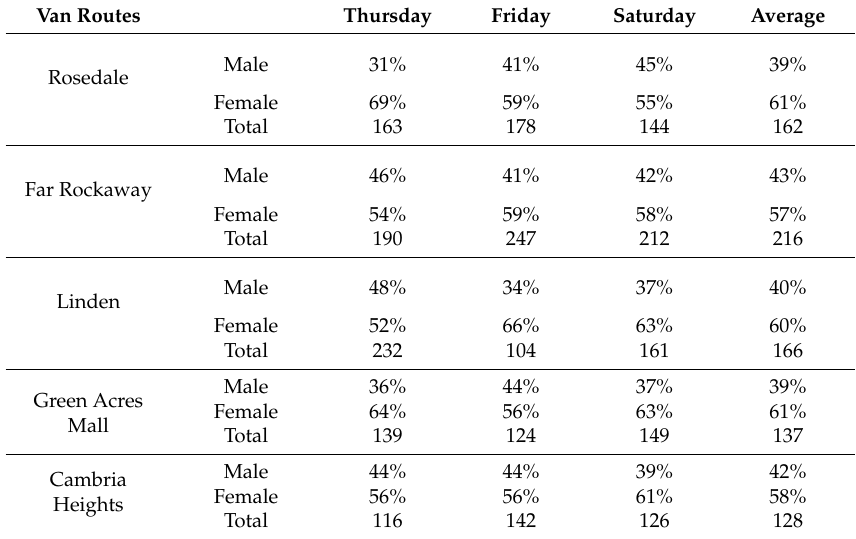
Table 2. Commuter van male and female ridership tally results on individual